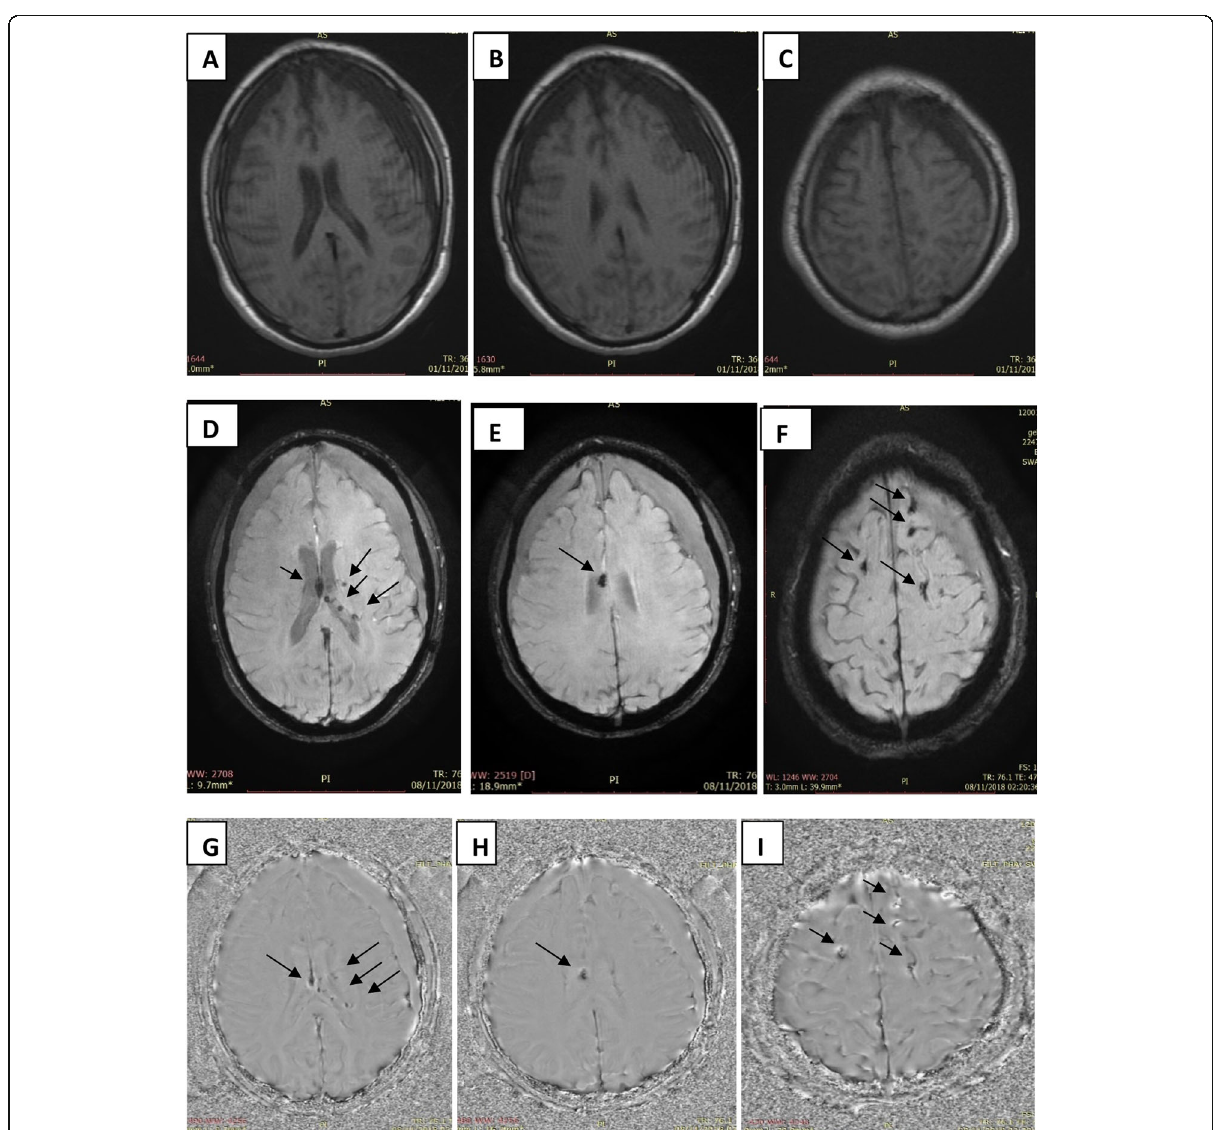
Fig. 3 Male patient aged 28 years old had road traffic accident and presented with disturbed conscious level and Glasgow coma scale = 6. MRI brain showed bilateral subdural hematomas together with multiple microhemorrhage at grey white matter interface, corpus callosum, and around the lateral ventricles denoting diffuse axonal injury that were inconspicuous in T1WI ( a , b, and c ) but more evident in SWI ( d , e, and f ) and confirmed to be microhemorrhage by filter phase ( g , h, and i ) displaying hypointense